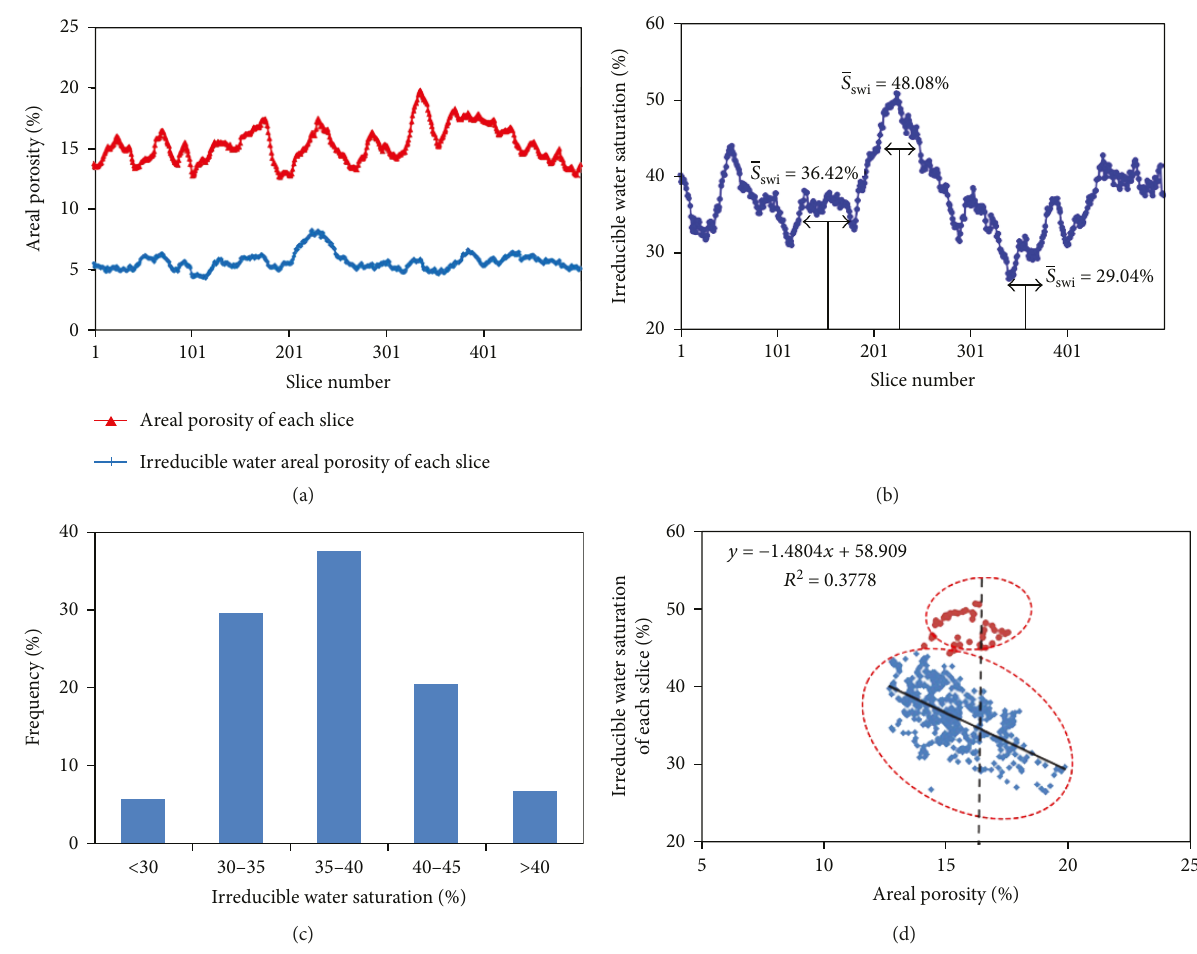
Figure 6: 2D distribution characteristics of irreducible water in core slices: (a) distribution of areal porosity and irreducible water porosity in 2D core slices; (b) distribution of irreducible water saturation of a 2D slice; (c) frequency histogram of irreducible water distribution in the core sample; (d) relationship between areal porosity and irreducible water